Question: Write a descriptive caption for this figure.
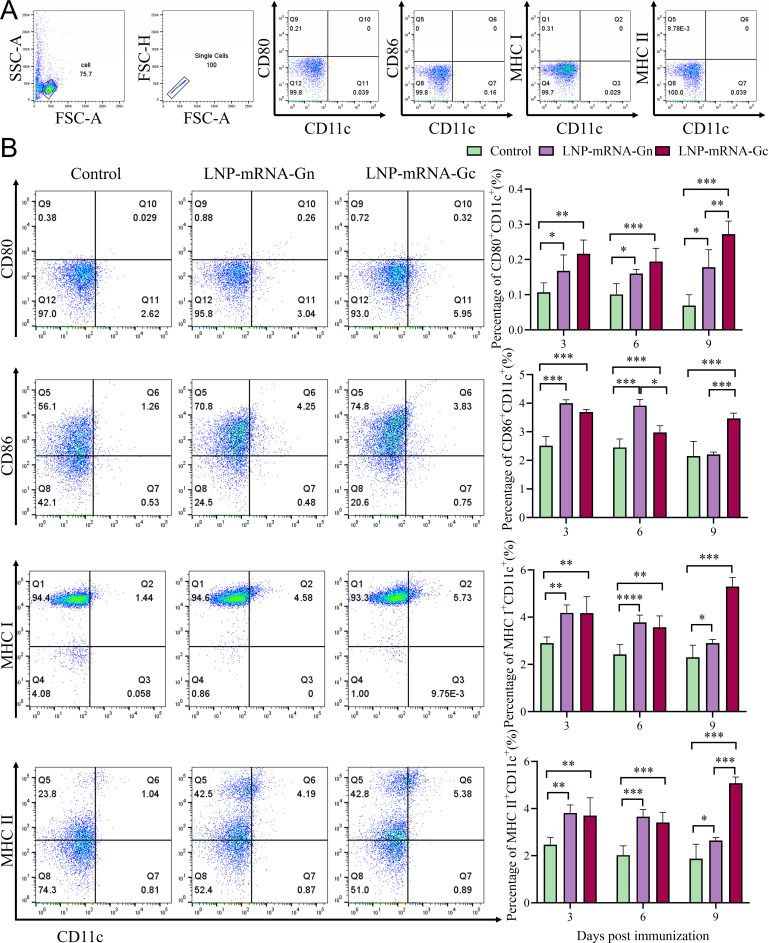
Answer: Activation of DCs in lymph nodes. ( A ) Gating strategies for analyzing DCs. ( B ) Inguinal LNs were collected at 3, 6, and 9 days postimmunization. Single-cell suspensions were prepared and stained separately with antibodies against DCs (CD11c + , CD80 + , CD86 + , MHC I + , and MHC II + ). A representative flow cytometric plot of activated DCs is shown. Statistical analysis of the percentages of activated DCs in the lymph nodes (15 wild-type mice per group; 5 mice per group per time point; values are means ± SEM; ANOVA with Tukey’s multiple comparisons test). * P < 0.05, ** P < 0.01 and *** P < 0.001.